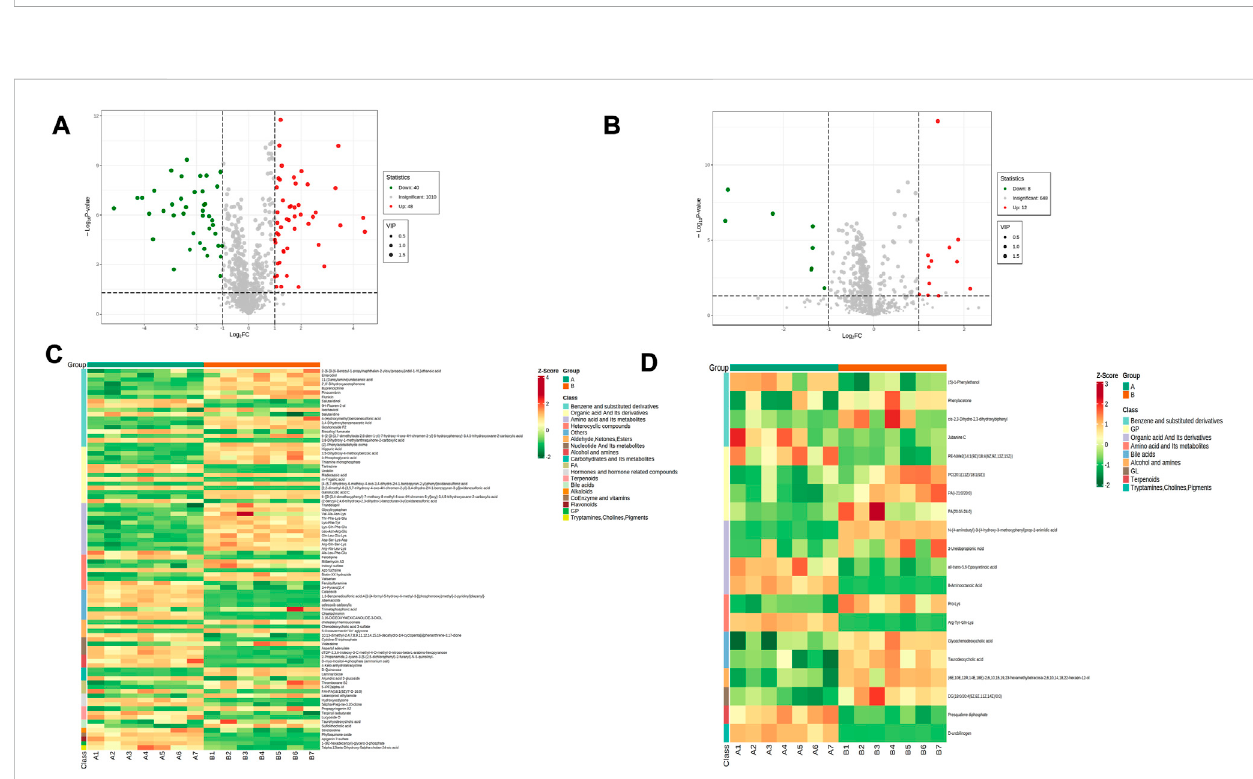
FIGURE 6 Expression of differential metabolites in groups A vs. B (A) volcano plot of differential metabolites under anionic conditions; (B) volcano plot of differentialmetabolites undercationicconditions; (C) heatmapofdifferentialmetaboliteexpressionbetweensamplesunderanionicconditions; (D) heat map of differential metabolite expression between samples under cationic